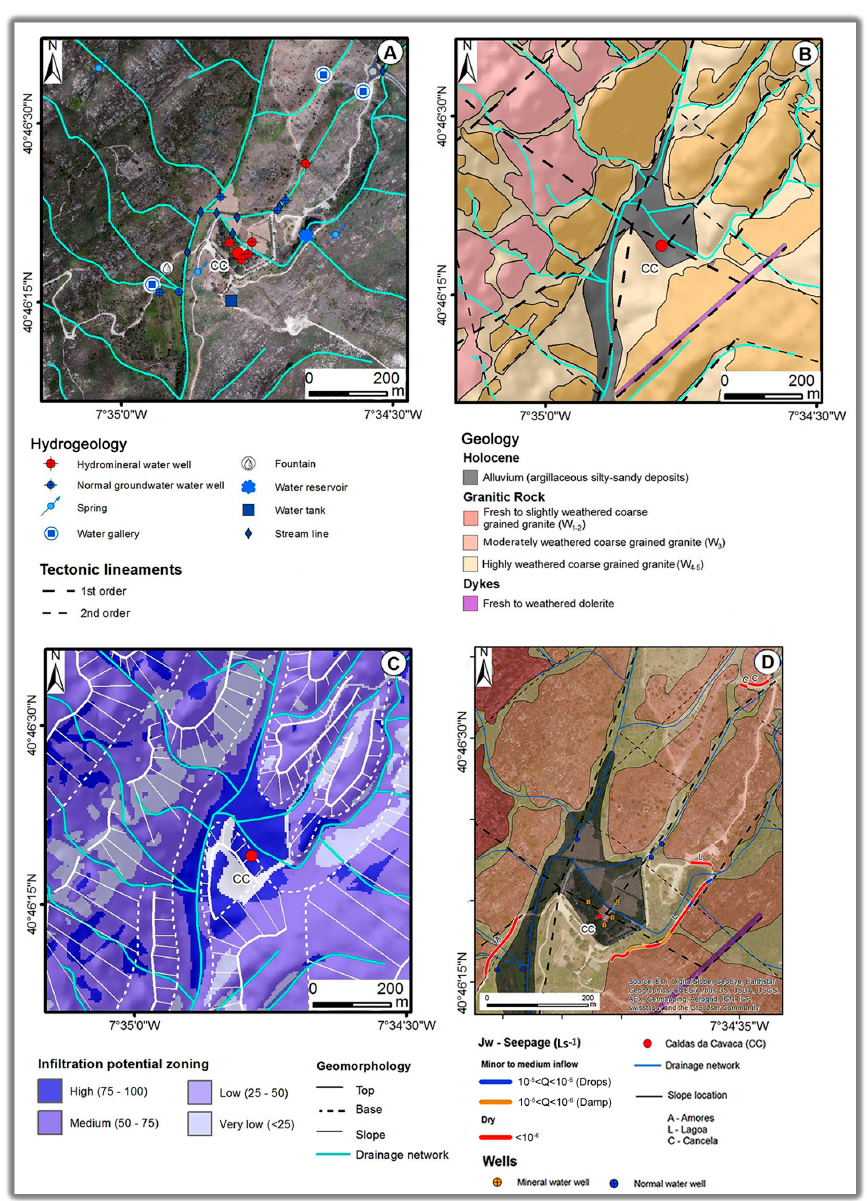
Figure 3. Local hydrogeological framework of Caldas da Cavaca site, revised and updated from [26,27,40]. Hydrogeological inventory ( A ); geology and geotechnical framework ( B ); hydrogeomorphology and infiltration potential zoning ( C ); hydrogeomechanical assessment based on seepage parameter (J W —joint water reduction) on selected rock masses ( D